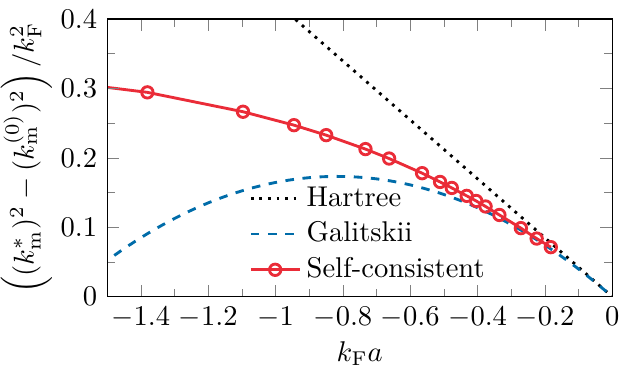
Figure 9: The quadratic shift of the energy minimum compared to the mean-field value. Our self-consistent calculation of the shift (red circles) is compared to the Hartree [ 56, 57, 64, 65 ] (black dotted line) and Galitskii [ 59, 66 ] (blue dashed line) results in the BCS